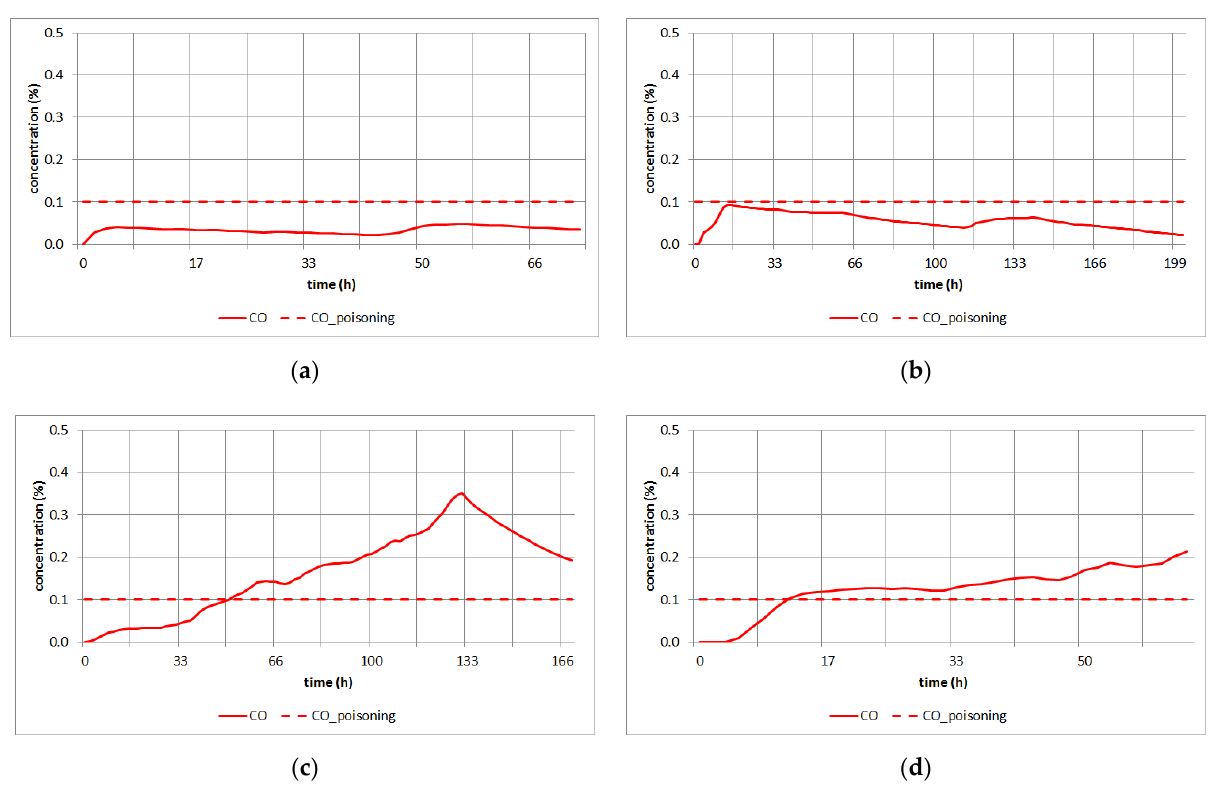
Figure 7. The impact of CO in terms of possible poisoning for the ( a ) experiment #1, ( b ) experiment #2, ( c ) experiment #3, and ( d ) experiment #4.